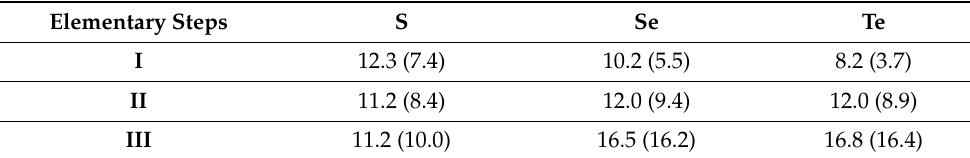
Table 2. Energy barriers for the oxidation of phenylchalcogenolates by H 2 O 2 (Scheme 9B). Values in parentheses were computed in water. Level of theory: (COSMO)-ZORA-OLYP/TZ2P. Data taken from